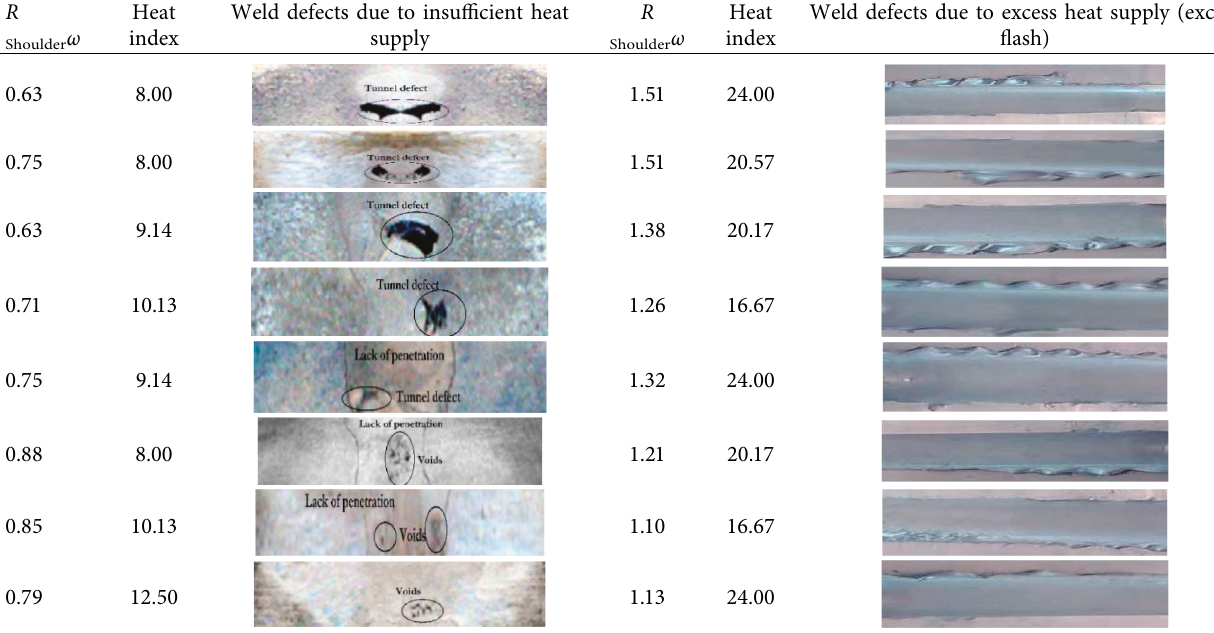
Table 3: Defects